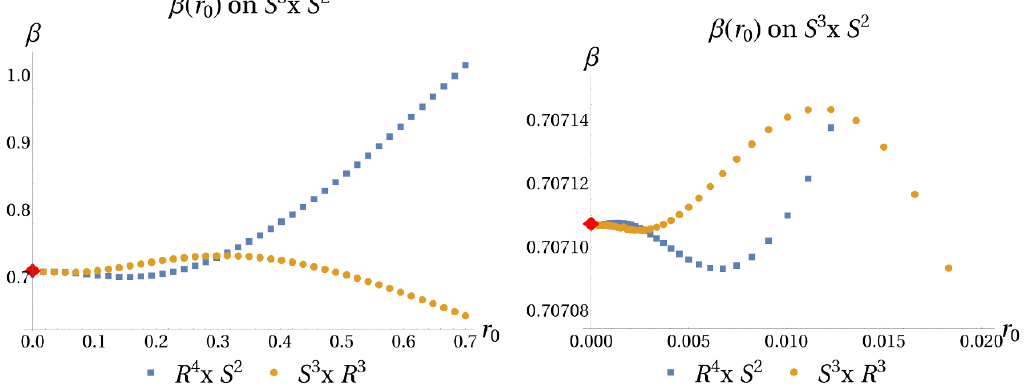
Figure 2 . The ratio of radii (cid:12) as a function of the closing radius r 0 for both topologies with conformal boundary S 3 (cid:2) S 2 . The red diamond is the analytical calculation for the singular ratio (cid:12) s